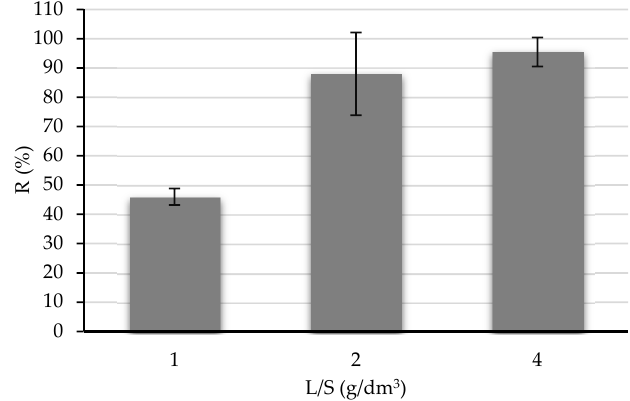
Figure 6. E ff ect of char dosage on the removal of Remazol Yellow (RY) from solution. Conditions: initial RY concentration = 20 mg / dm 3 ; solution pH = natural; contact time = 150 min. Error bars of duplicates are presented.